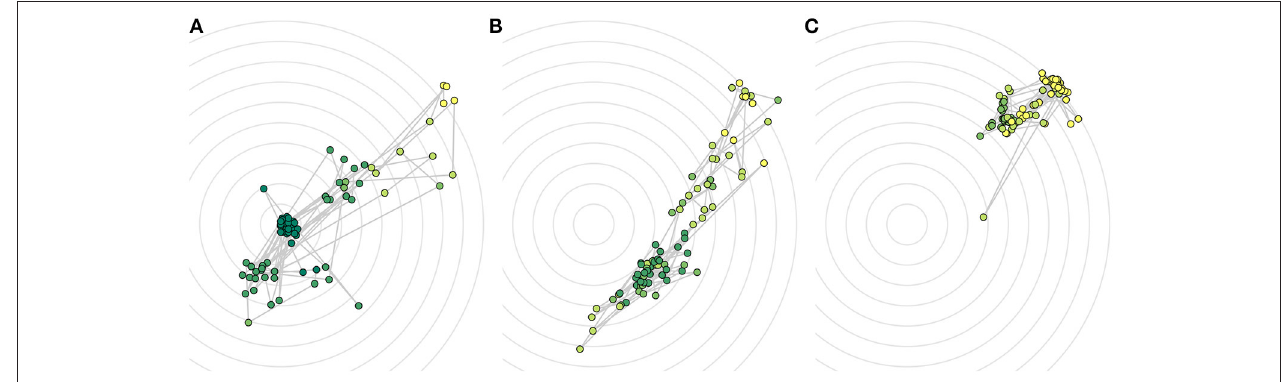
FIGURE 6 | Individual visualizations for all roll-outs in one prototypical session for (A) successful, (B) premature, and (C) unsuccessful convergence. Colors show score given (darker shades correspond to higher scores, brighter shades correspond to lower scores). Concentric circles show equidistant positions around the cup, which is located in the